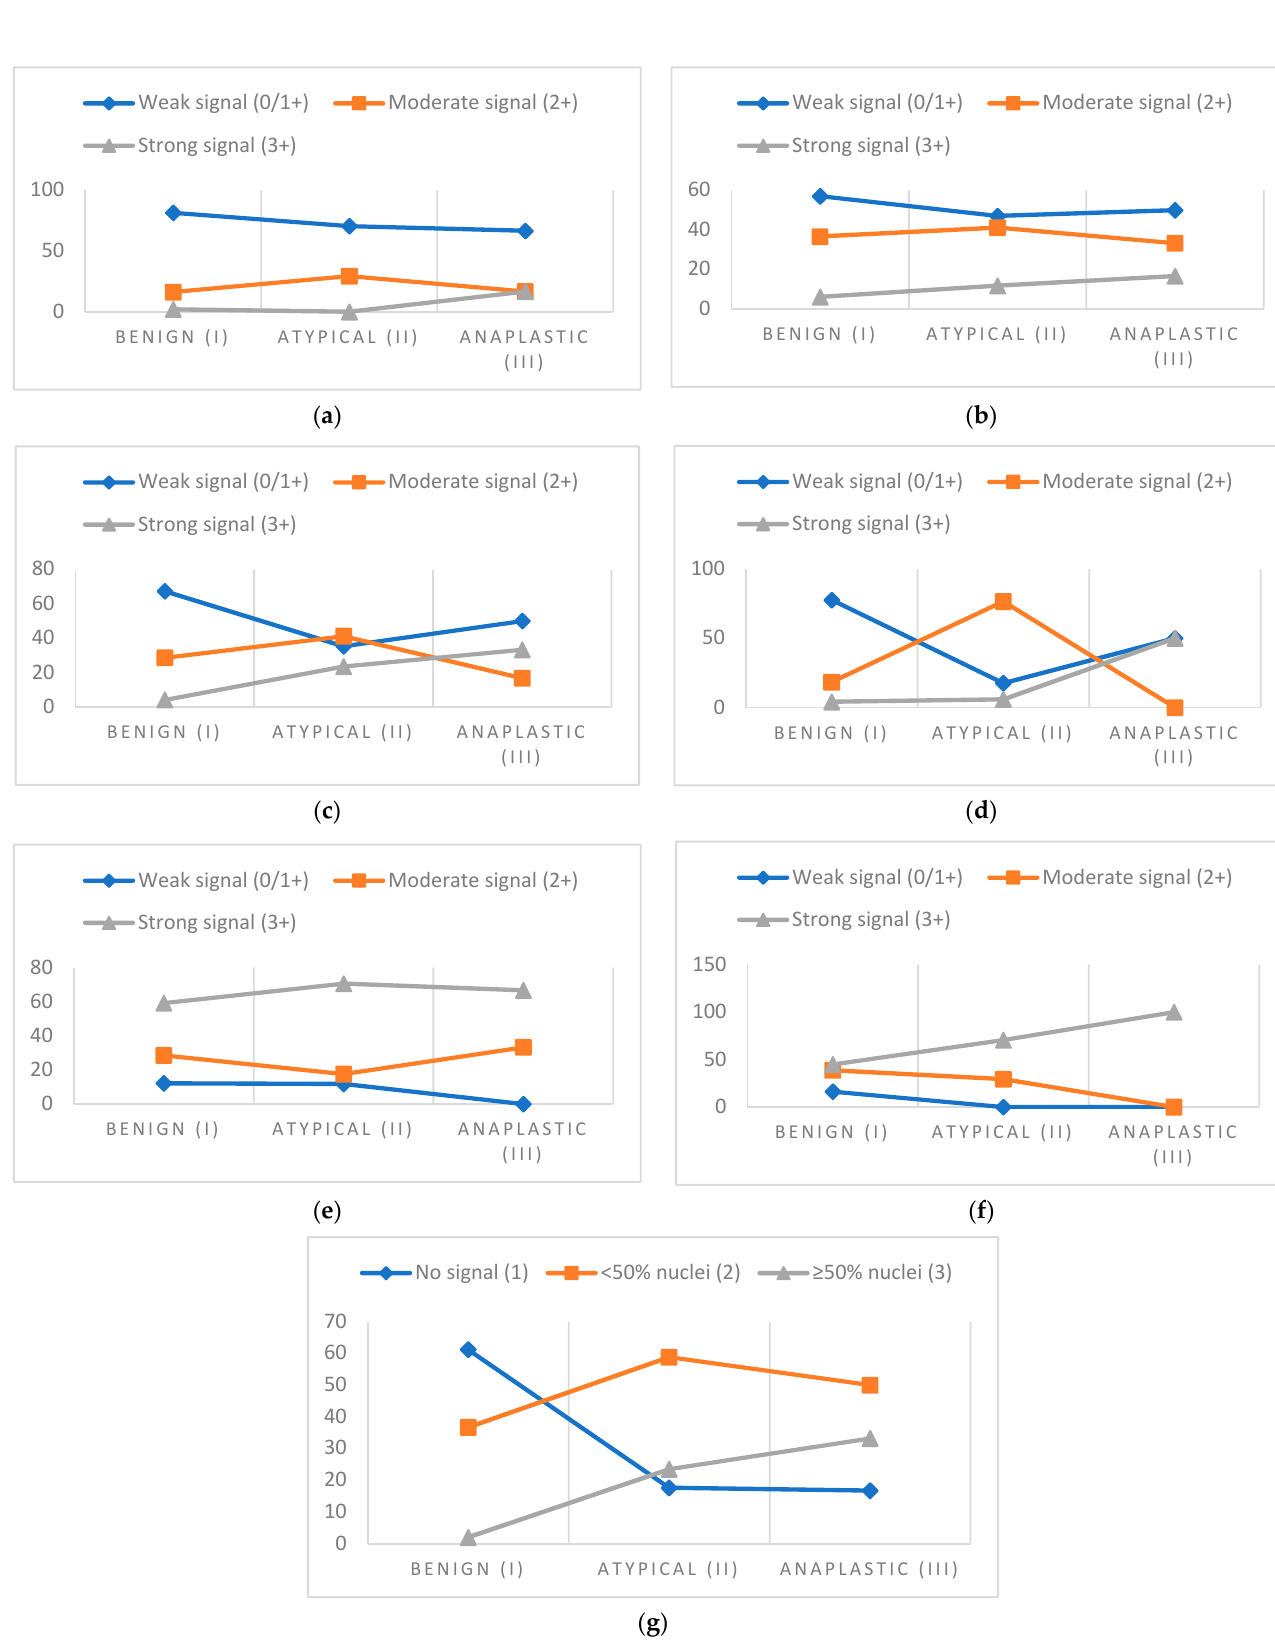
Figure 5. Percent of signal strength in different grades of meningioma shown for ( a ) E-cadherin, ( b ) N-cadherin, ( c ) total β -catenin, ( d ) NON-P β -catenin, ( e ) TWIST1, ( f ) SNAIL & SLUG in cytoplasm, and ( g ) SNAIL & SLUG in nuclei.